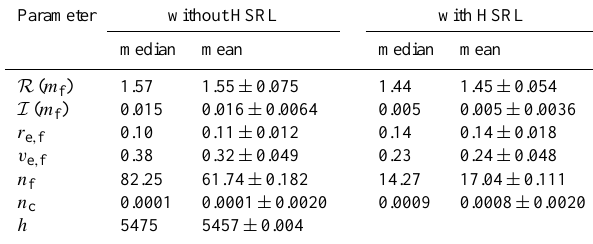
Table 3. Directly retrieved aerosol parameters. The mean and me- dian are calculated for the set of optimizations. Uncertainties (de- noted ± ) are the median value returned by the optimization routine. Ratios are the standard deviation of the set of optimization results divided by the median optimization